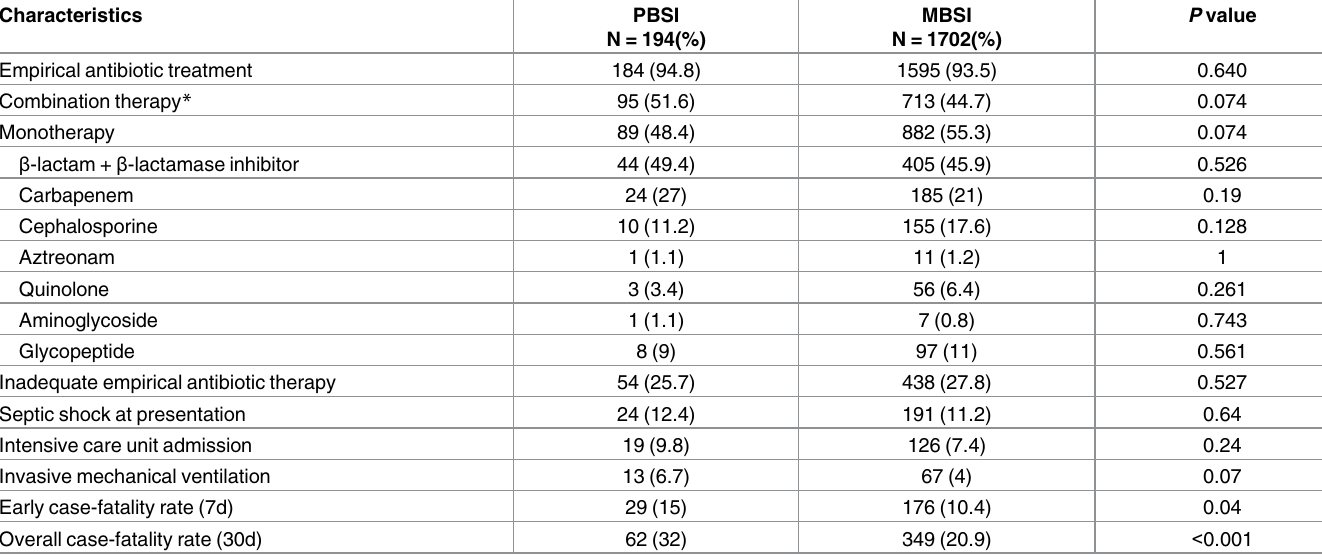
Table 4. Therapeutic management and outcomes of polymicrobial bloodstream infection and monomicrobial bloodstream infection.